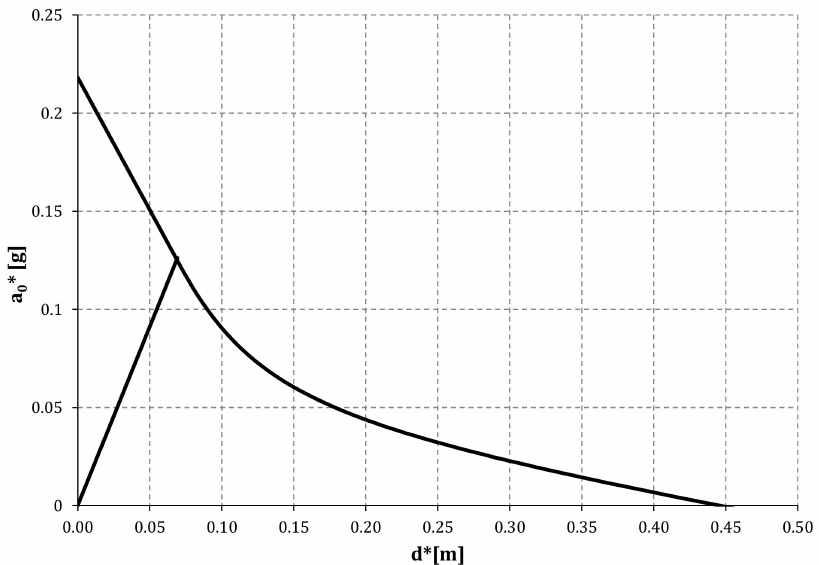
Figure 5. Capacity curve for collapse mechanism 2 - APO of the Vatopedi